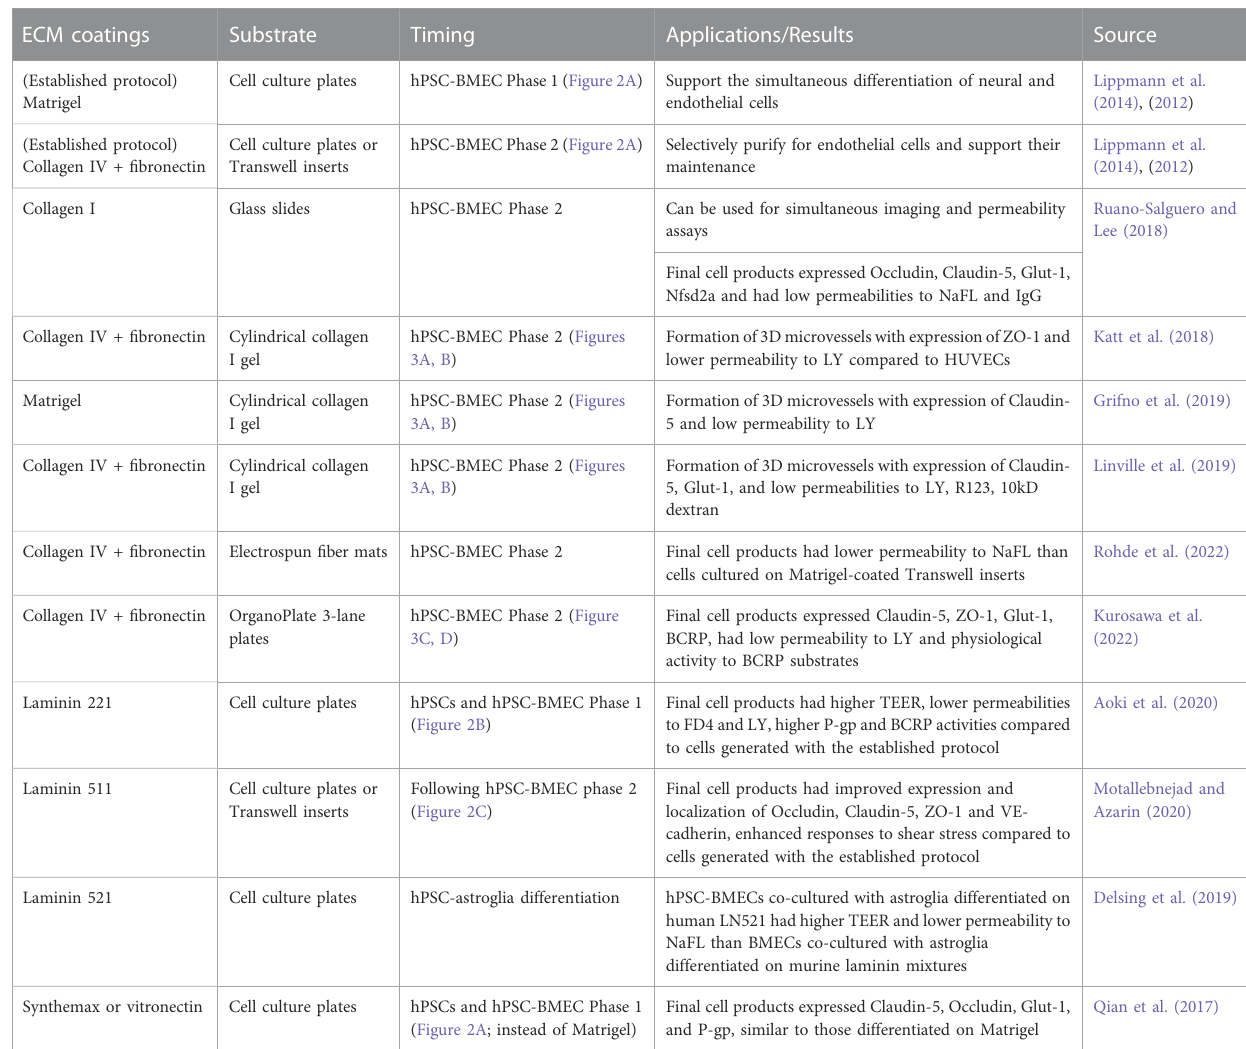
TABLE1ECMcoatingsusedin invitro hPSC-BBBmodels.SummaryofECMcoatings usedinrecent invitro hPSC-BBBmodels,comparedtotheestablishedprotocol described in section 3.1.2 and illustrated in Figure